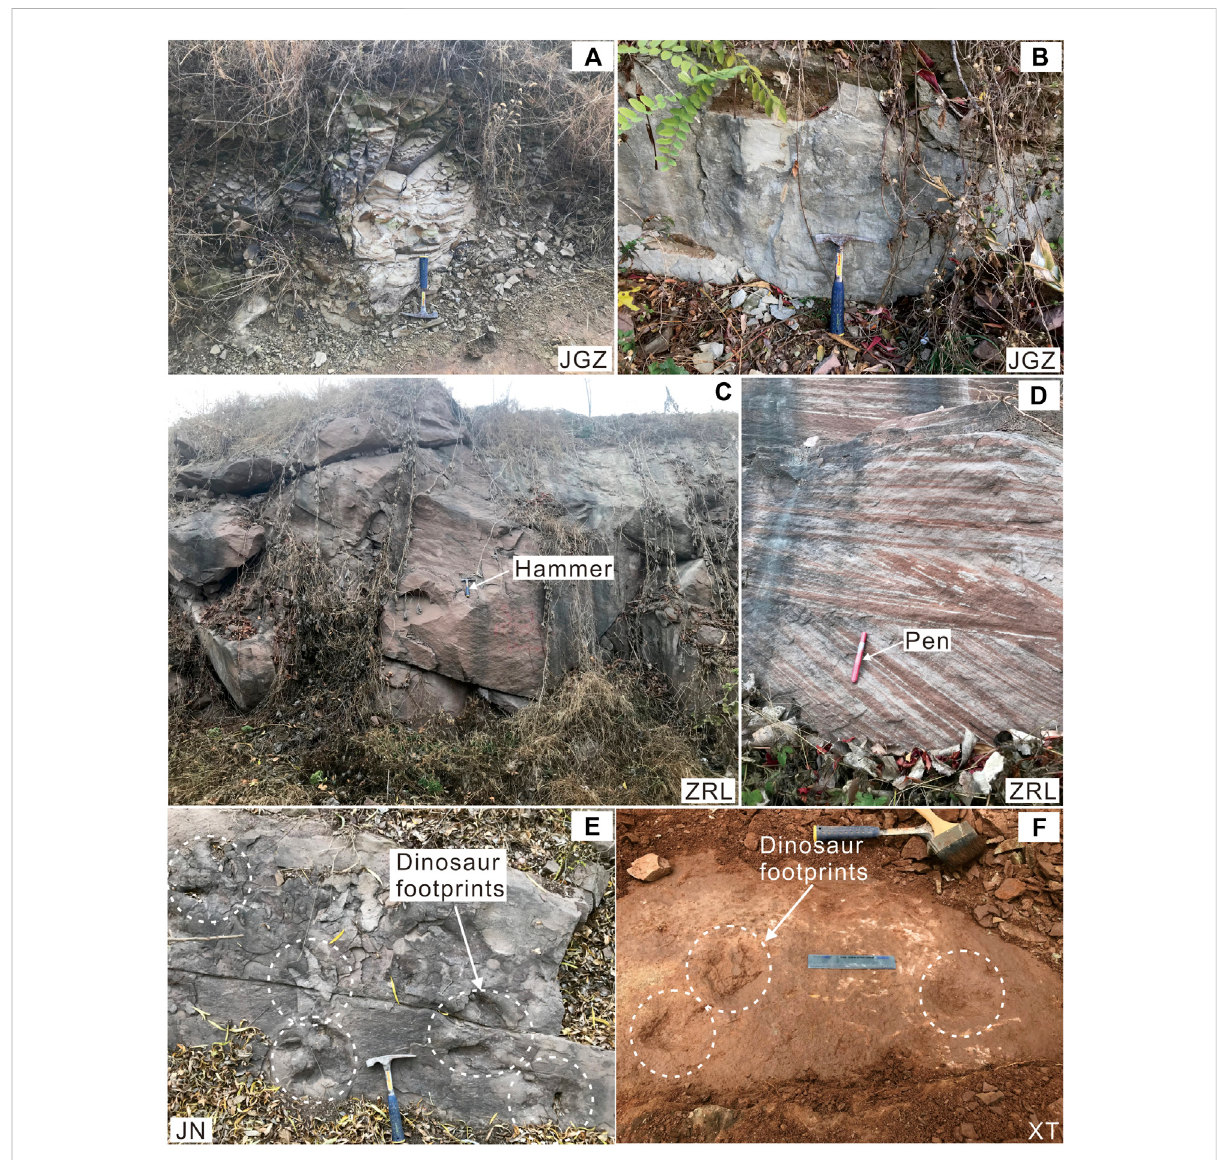
FIGURE 4 Field photographs showing outcrops and exposures of the studied samples in the western Shandong province and Tanlu fault zone. (A – B) Exposures of the lowermost part of the Santai Formation consisting of grey- or grey-white sandstone; (C – D) exposures of the upper part of the Santai Formation characterized by typical sedimentation of fl uvial facies, developing typical wedge-shaped cross-bedding; (E) grey- or grey-white sandstone with the dinosaur tracks in the Houzuo mountain; (F) brick-colored sandstone with the dinosaur tracks within the upper part of the Santai Formation in the Mengyin